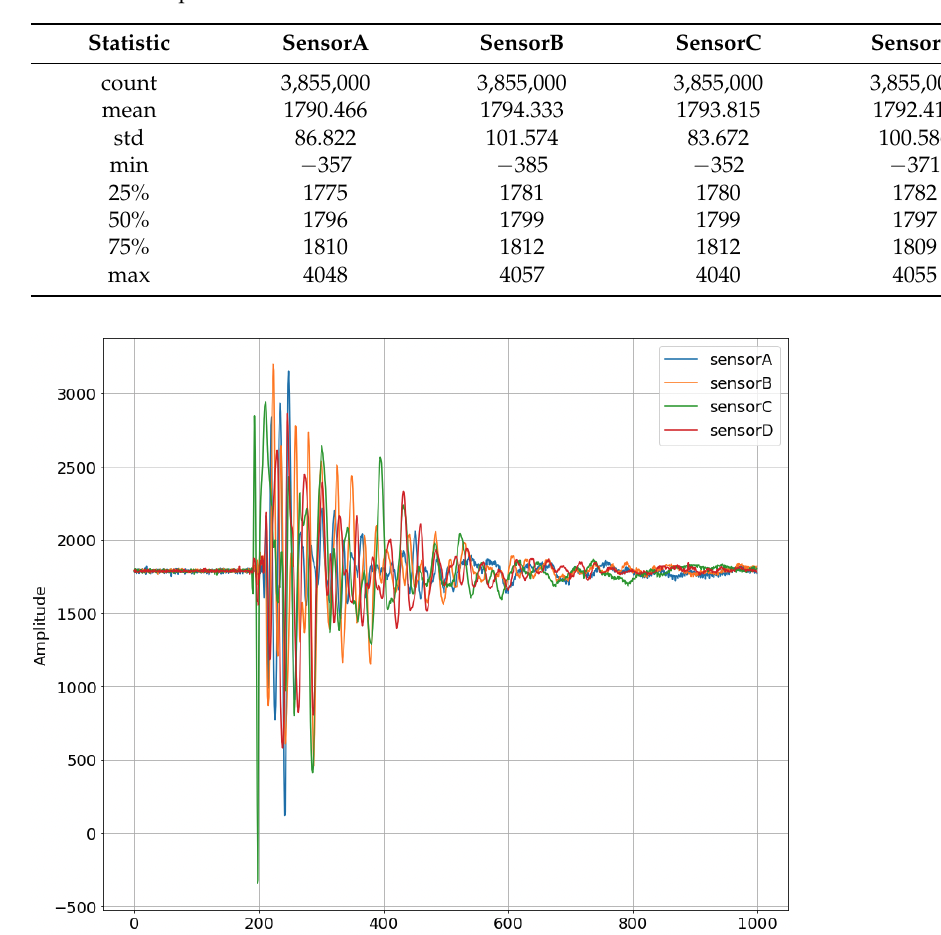
Figure 8. Raw sensor values over the first 1 k